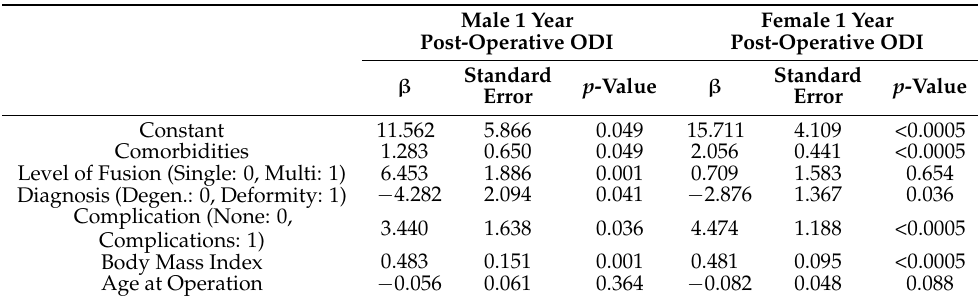
Table 6. Linear regression model of post-op ODI at 1 year for male and female.